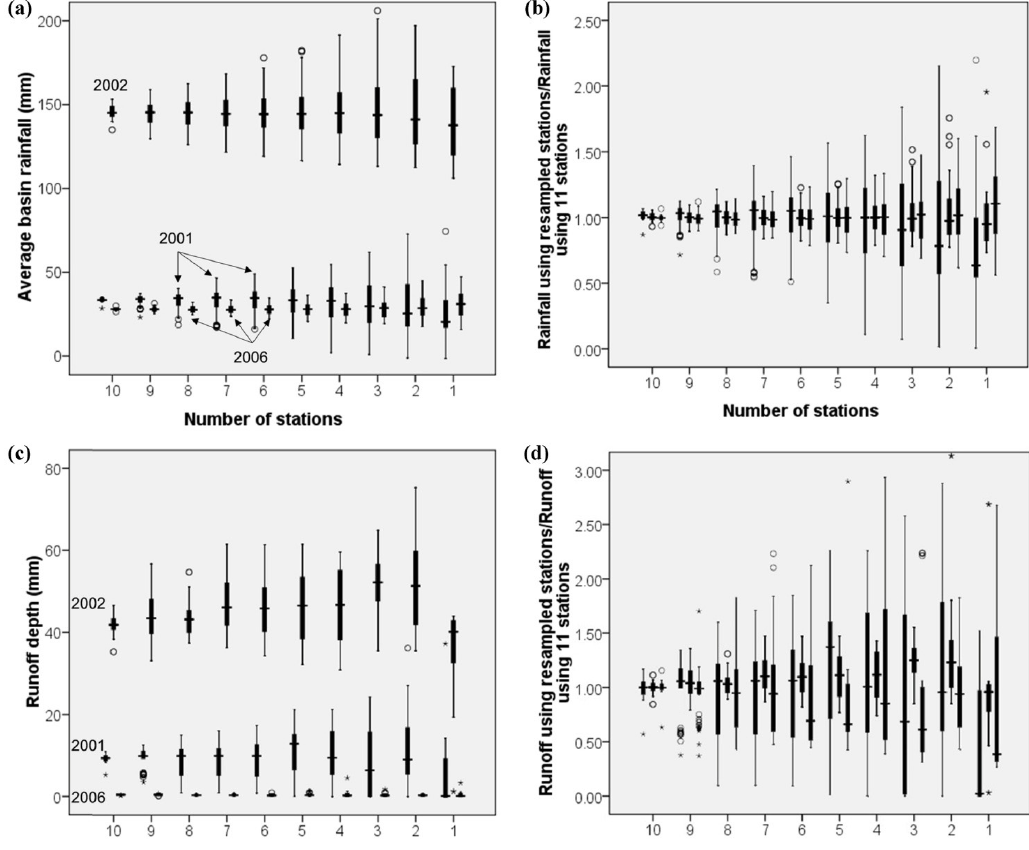
Figure 7. Uncertainty of the three rainfall-runoff events on different number of stations in the upstream of the Qingjian River basin: ( a ) Average basin rainfall, ( b ) Non-dimensional uncertainty of average basin rainfall, ( c ) Simulated runoff depth and ( d ) Non-dimensional uncertainty of simulated runoff depth. Note: every three boxes represent the results of 2001, 2002 and 2006 events from left to right.